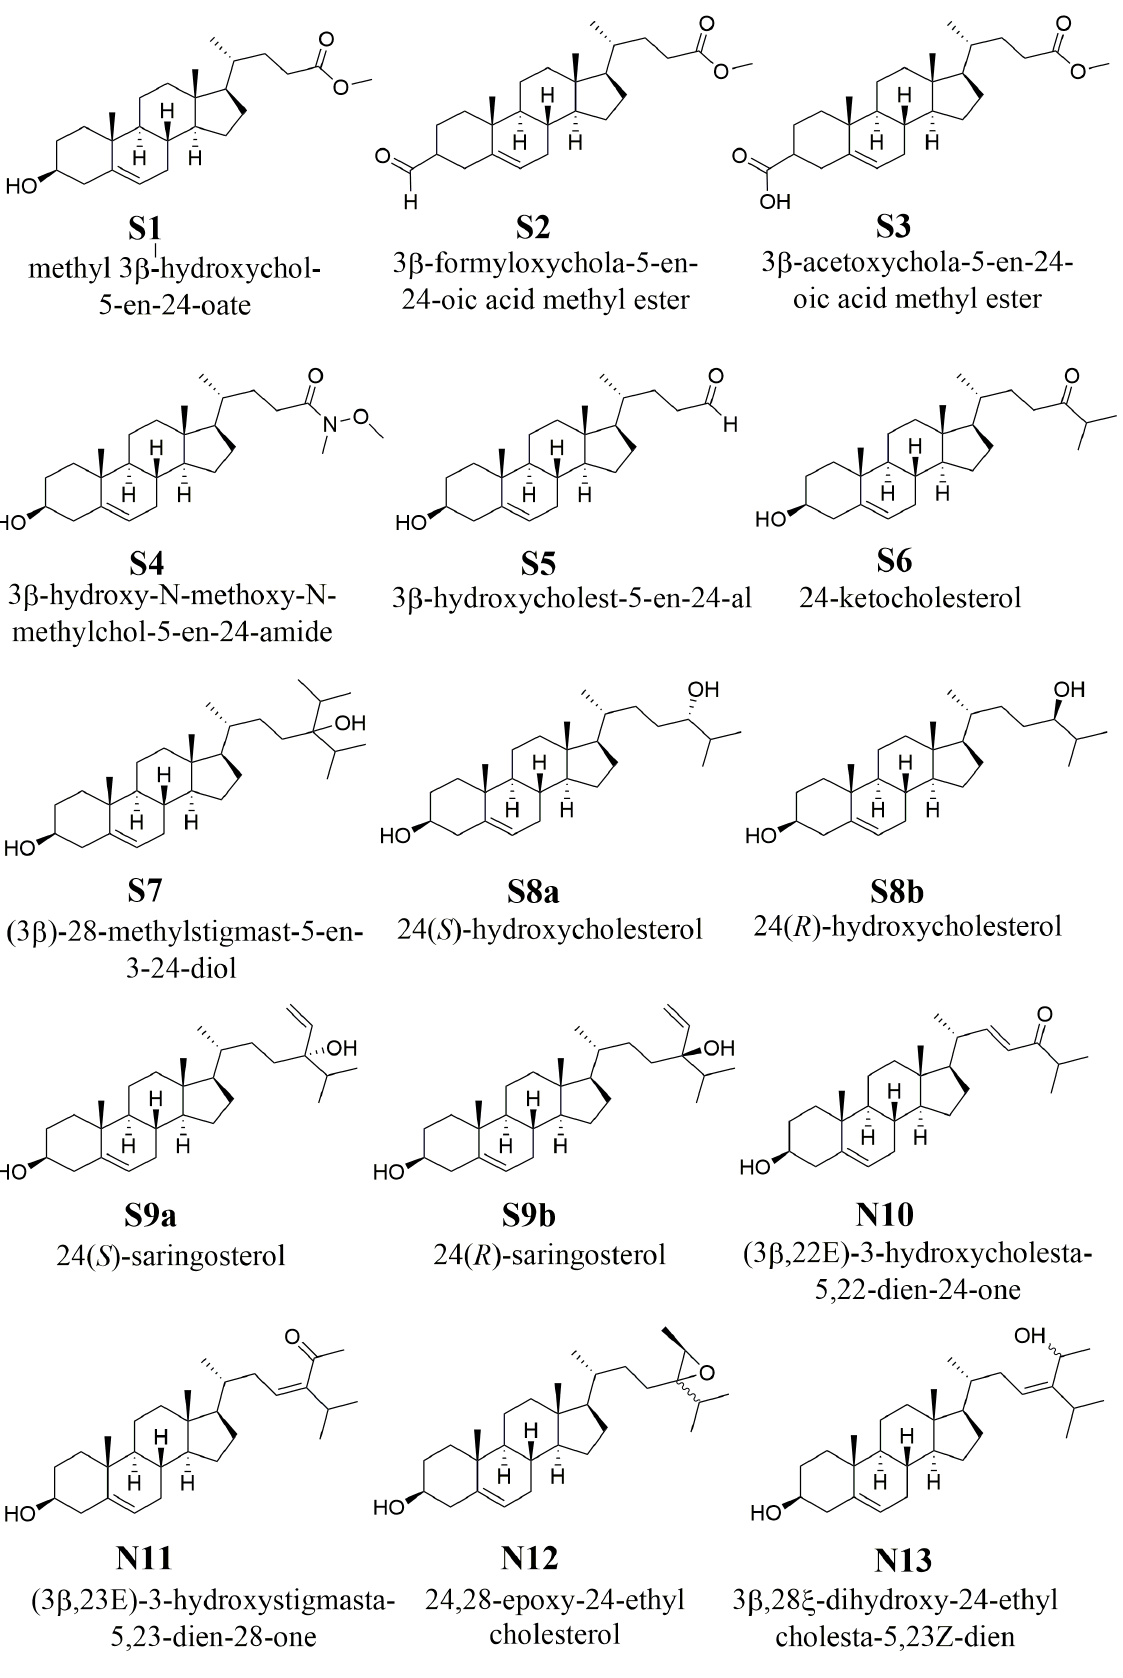
Figure 1. Chemical structures of S1-S9 and N10-N1